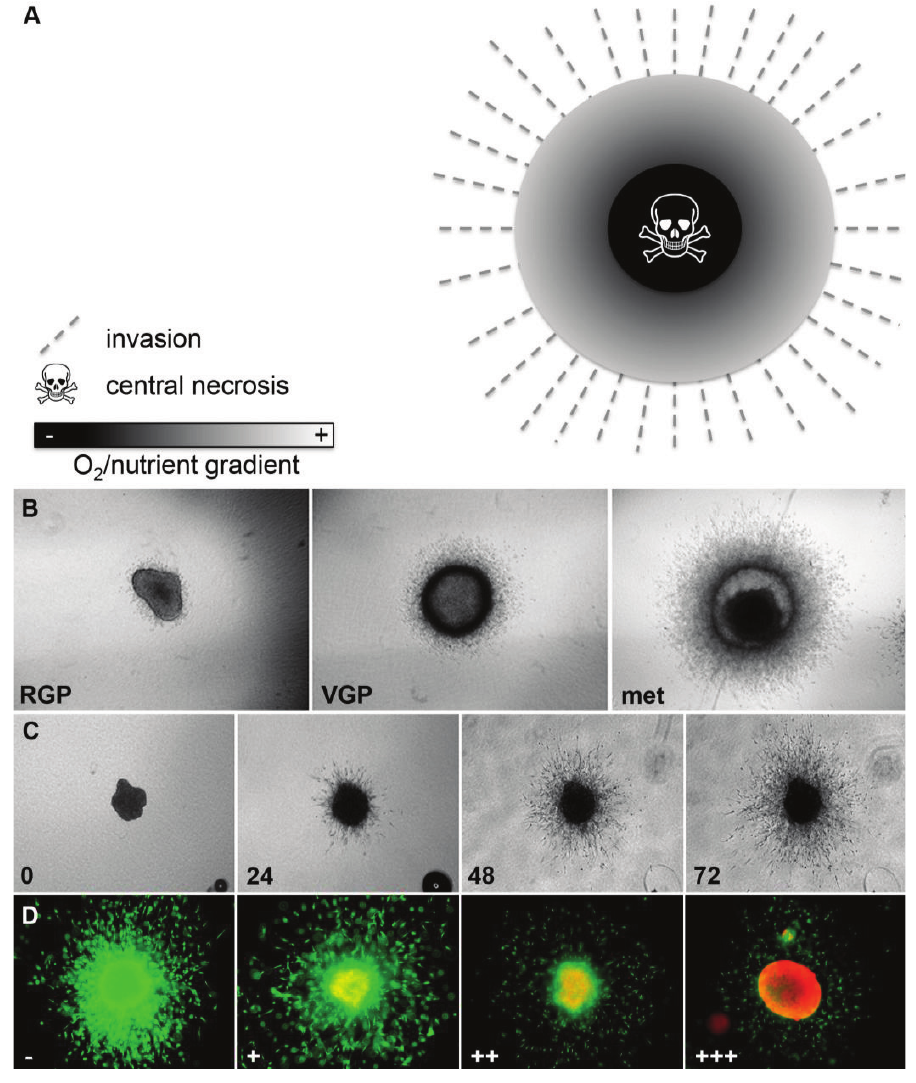
Figure 2. Melanoma spheroid model. ( A ) Image demonstrating oxygen and nutrient gradient within a 3D spheroid, central necrosis and invasion of melanoma cells into the tumor stroma; ( B ) Growth and invasion behavior of melanoma spheroids reflects that of the original tumors: radial (RGP), vertical growth phase (VGP), metastasis (met); ( C ) Growth and invasion of a spheroid derived from a metastatic cell line (numbers: time in h); ( D ) Spheroid treated with increasing doses of the BRAF inhibitor vemurafenib (−, +, ++, +++) and stained with a live/dead assay (green: calcein-AM, live; red: ethidium bromide, dead). Note the increasing growth and invasion inhibition, as well as cell